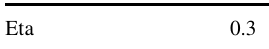
Table 6 The parameters of